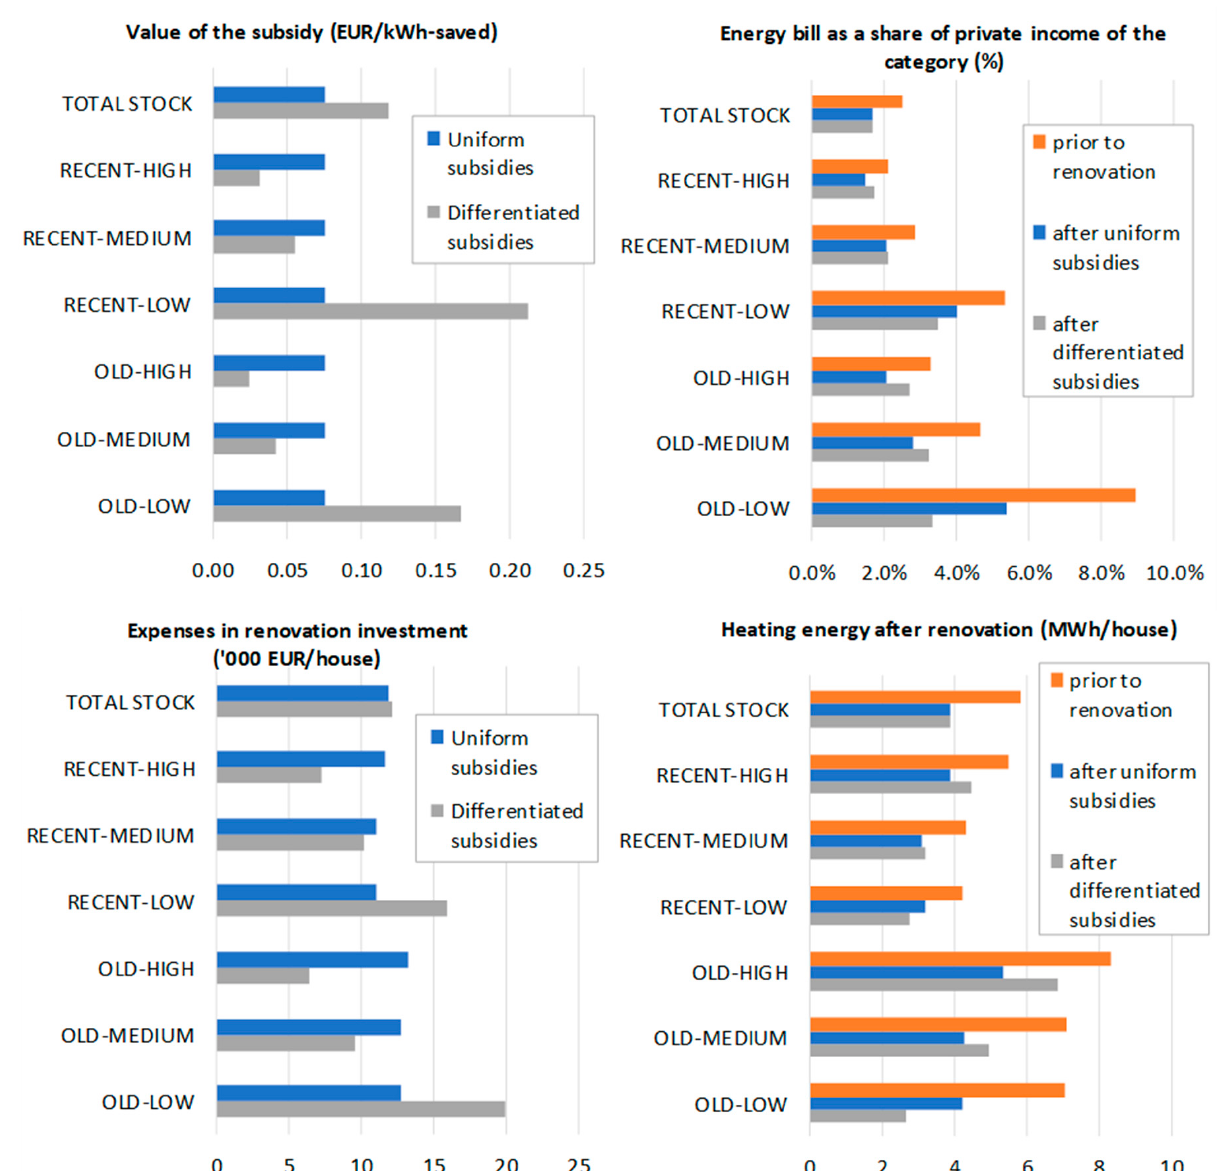
Figure 5. Model results for the subsidy policy case.